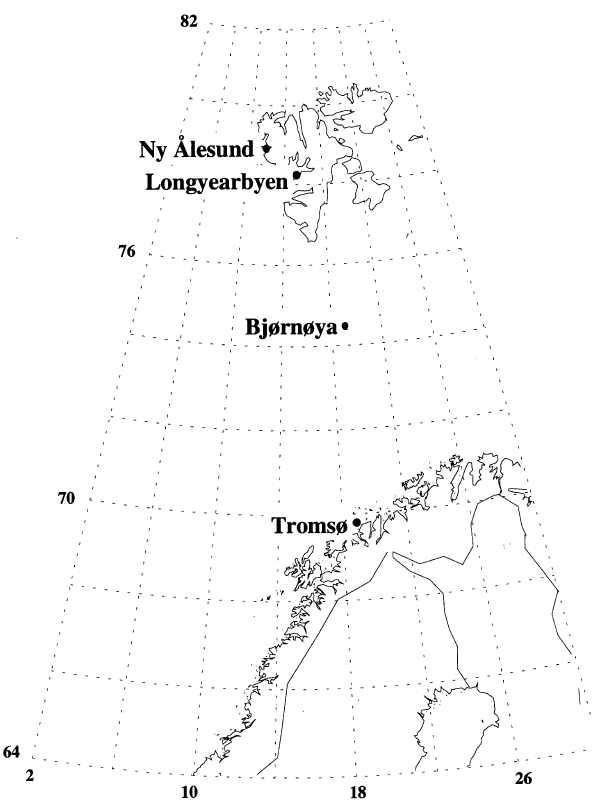
Fig. 1. Map showing satellite receiving system